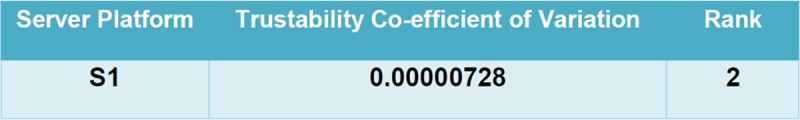
Trust Rank Table.